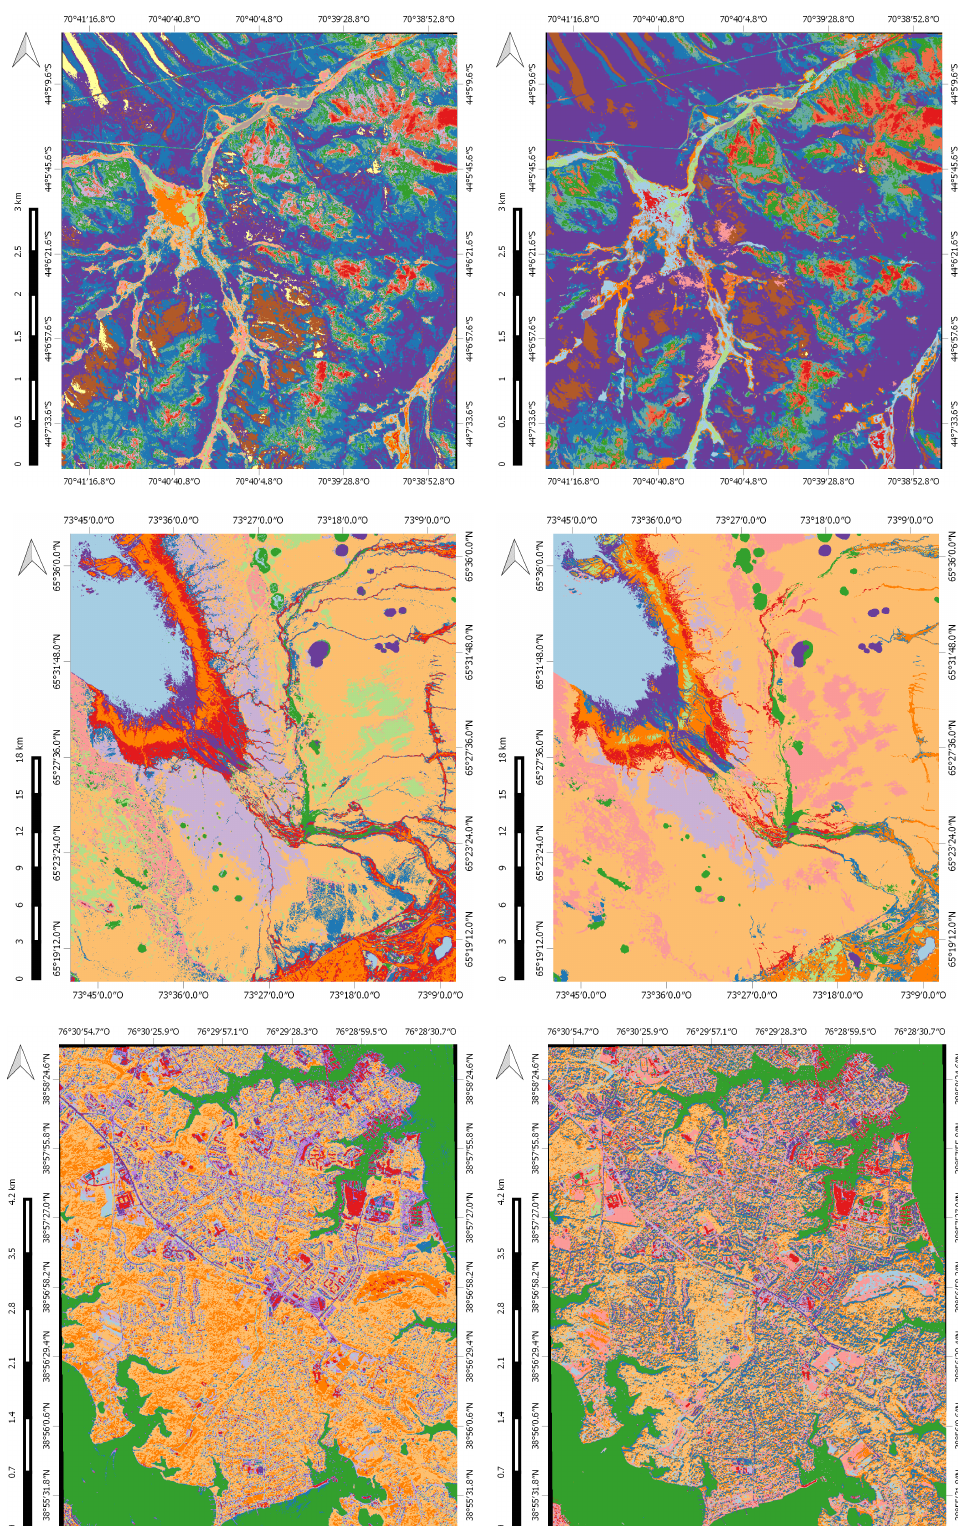
Figure 9. Region-merging methods’ comparison. Co-occurrence in superpixels results in the left column and superpixel characterization in the right column. Upper row: image ARGENTINA (15 final spectral clusters). Middle row: image CANADA1 (10 final spectral clusters). Lower row: image MARYLAND (10 final spectral clusters). Colors have no special